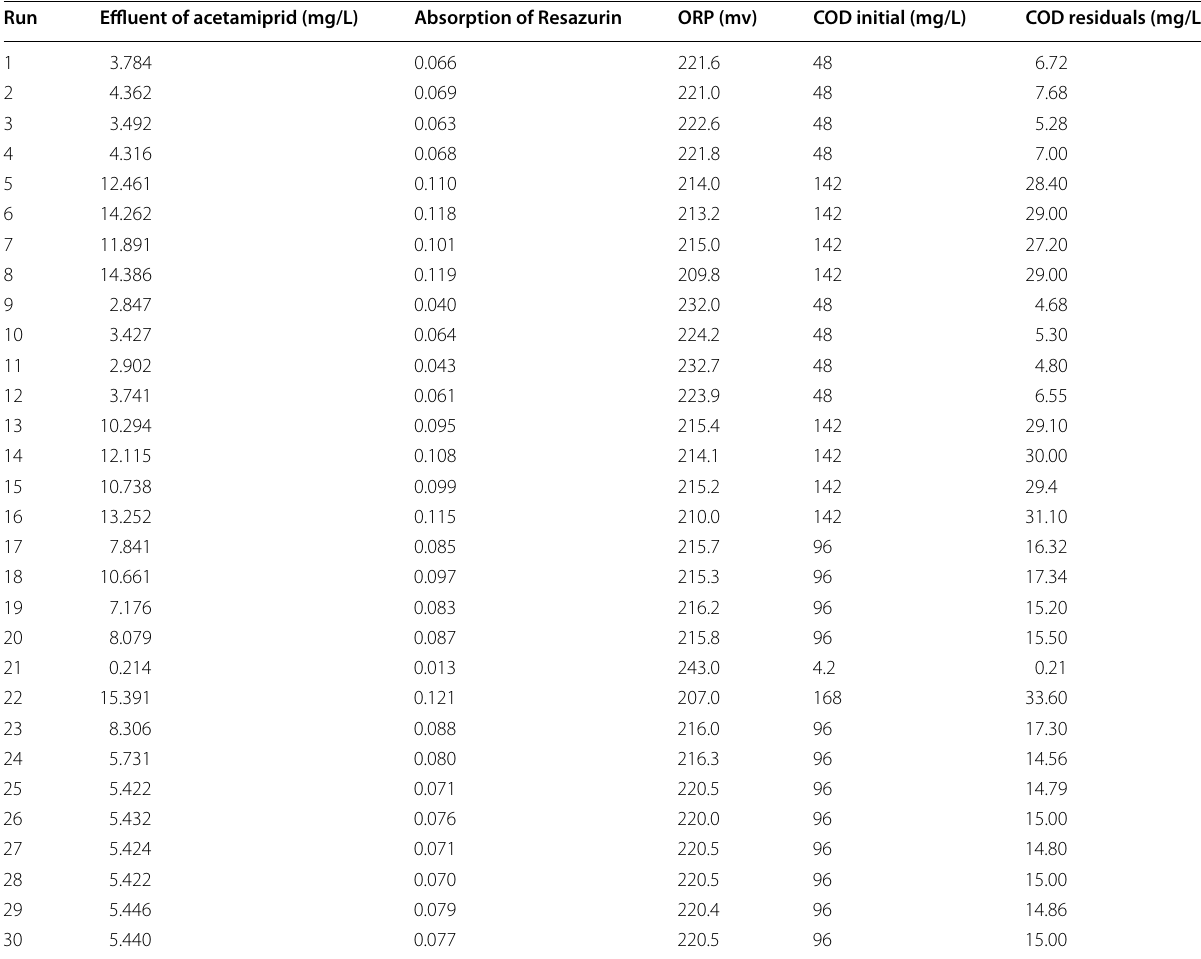
Table 5 Results of the experimental ORP, COD and absorption of Resazurin Run Effluent of acetamiprid (mg/L) Absorption of